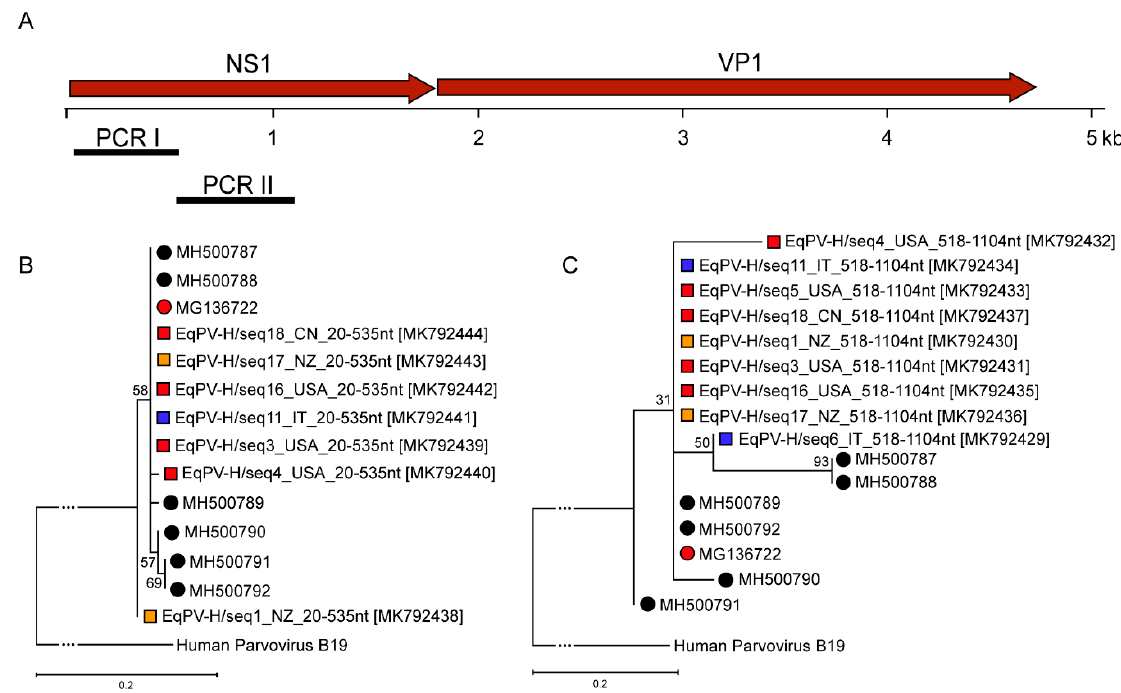
Figure 3. ( A ) Genomic organization of EqPV-H and primer positioning for PCR I-II. ( B ) Phylogenetic tree based on the fragments generated using PCR I. ( C ) Phylogenetic tree based on the fragments generated using PCR II. Evolutionary history was inferred by using the maximum likelihood method and general time reversible model. The trees with the highest log likelihood are shown. Red corresponds to North America, while blue indicates serum samples originating from Europe and orange matches samples from Oceania. Black corresponds to Asian strains. Circles indicate previously published EqPV-H sequences identified by various groups, whereas squares label newly found EqPV-H sequences within this study. Human parvovirus B19 was used as outgroup to root the tree. Table 3. The newly identified specimens were submitted to NCBI and were assigned with respect to the serum ID and the land of origin.